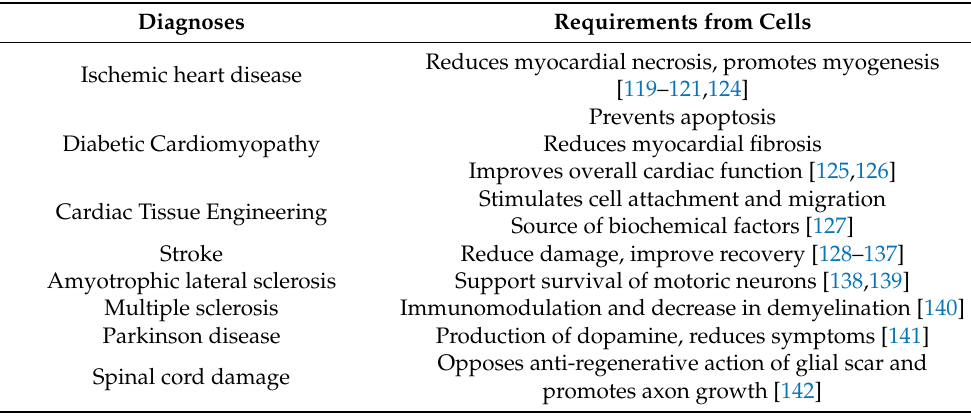
Table 1. Overview of pathological entities and reported beneficial effects of